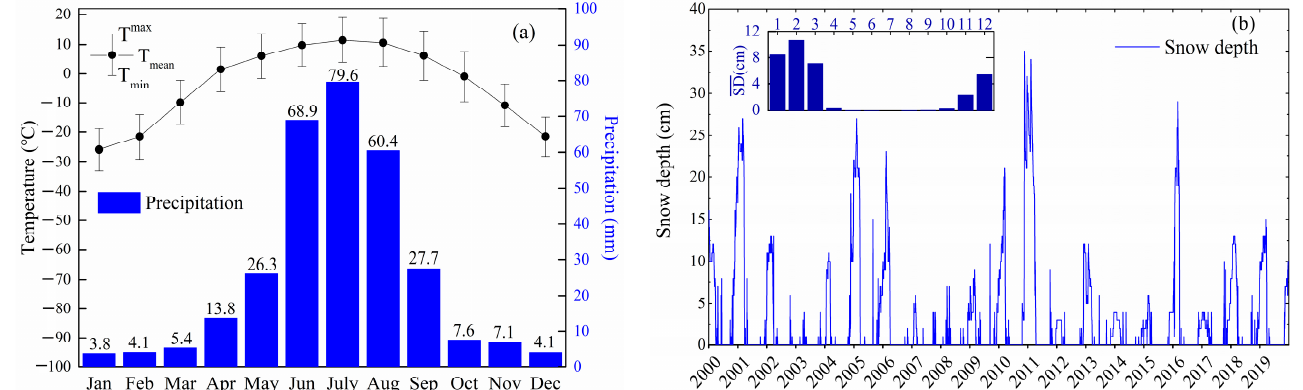
Figure 3. ( a ) The monthly mean precipitation and temperature at the Bayanbulak meteorological station from January 2000 to December 2019. ( b ) Bayanbulak meteorological station time series of daily snow depth, with a monthly histogram of mean snow depth from January 2000 to December 2019 in the inset figure.